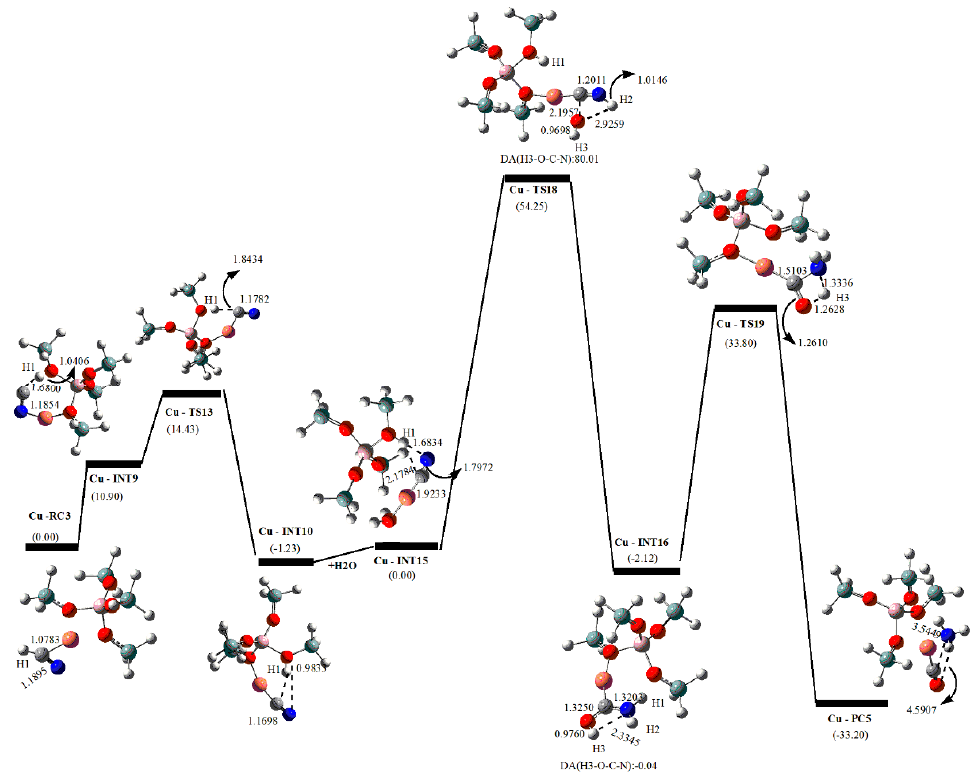
Figure 8. B3LYP/6-31++G (d,p)-optimized structures (in Å) of the stationary points of hydrolysis of HCN with Cu-ZSM5 in the gas phase for the path E. The values correspond to the relative free energy ( ∆ G) in kcal/mol with respect to the separate reactants.